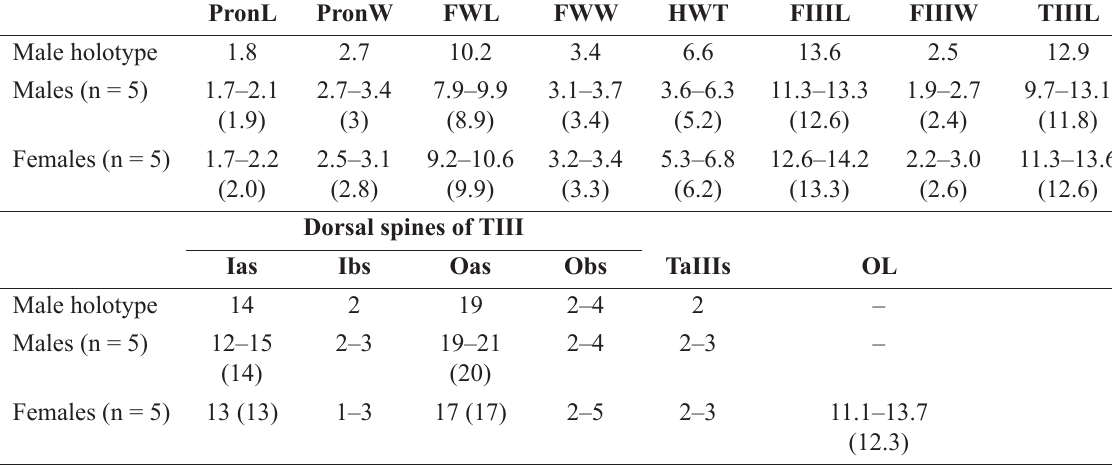
Table 8. Measurements of Nisitrus malaya Robillard & Tan sp. nov. (in mm, means in